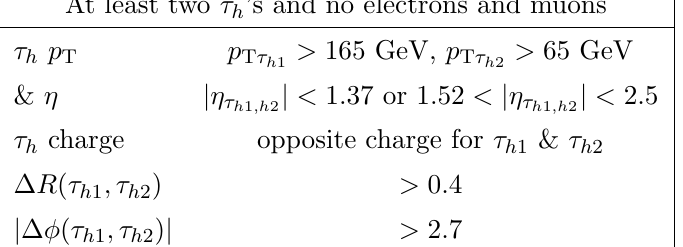
Table 5. Summary of cuts for the ATLAS DY (cid:28)